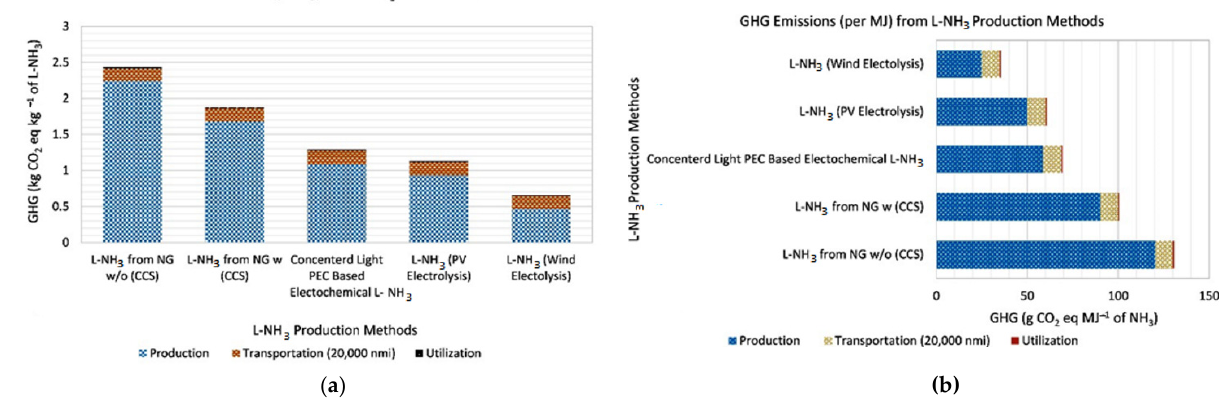
Figure 12. Comparison of greenhouse gas emissions from different liquid ammonia production methods. ( a ) kg of CO 2 per kg of NH 3 , and ( b ) g of CO 2 per equal MJ of NH 3 . Reprinted with permission [56].